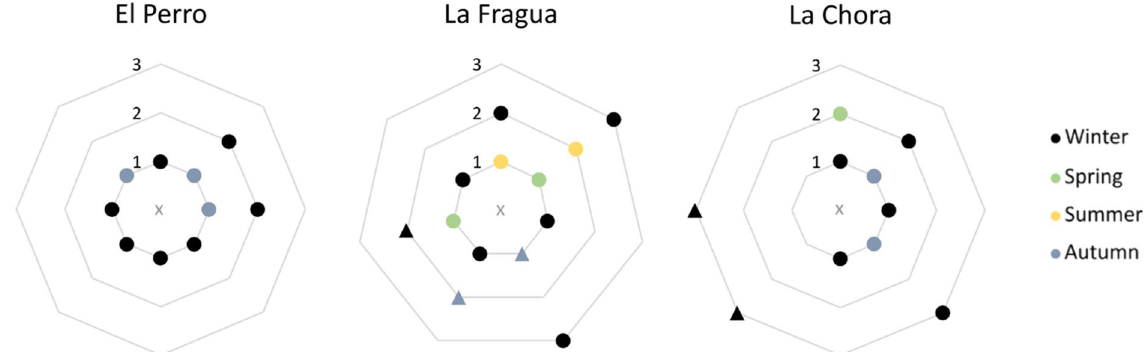
Figure 4. Delineative collection radius at the studied archaeological sites. The centre of each graph is the location of the shell midden. The concentric lines represent the different collection areas with a relative measure of distance from the site itself, from 1 (closest) to 3 (farthest). In El Perro and La Fragua 1 = open coast, 2 = lower estuary, 3 = upper estuary. In La Chora: 1 = upper estuary, 2 = lower estuary, 3 = open coast. The triangles indicate shells excavated from different units within the site (i.e. 1.4 in La Fragua and 104 in La Chora).